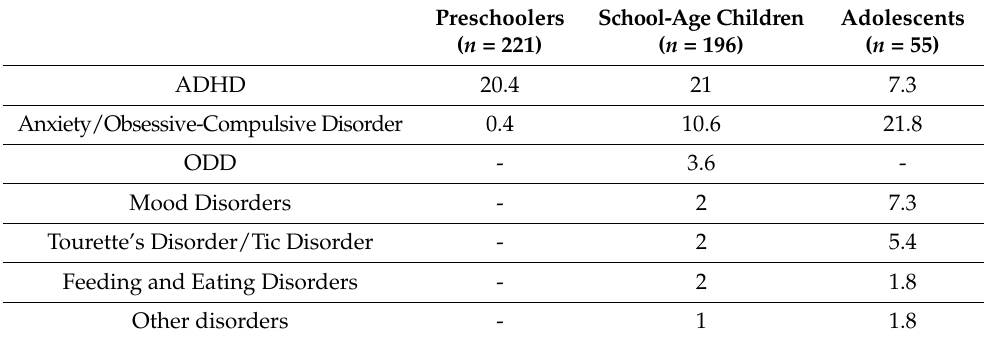
Table 1. Distribution of comorbid psychiatric disorders among children and adolescents with ASD (%).